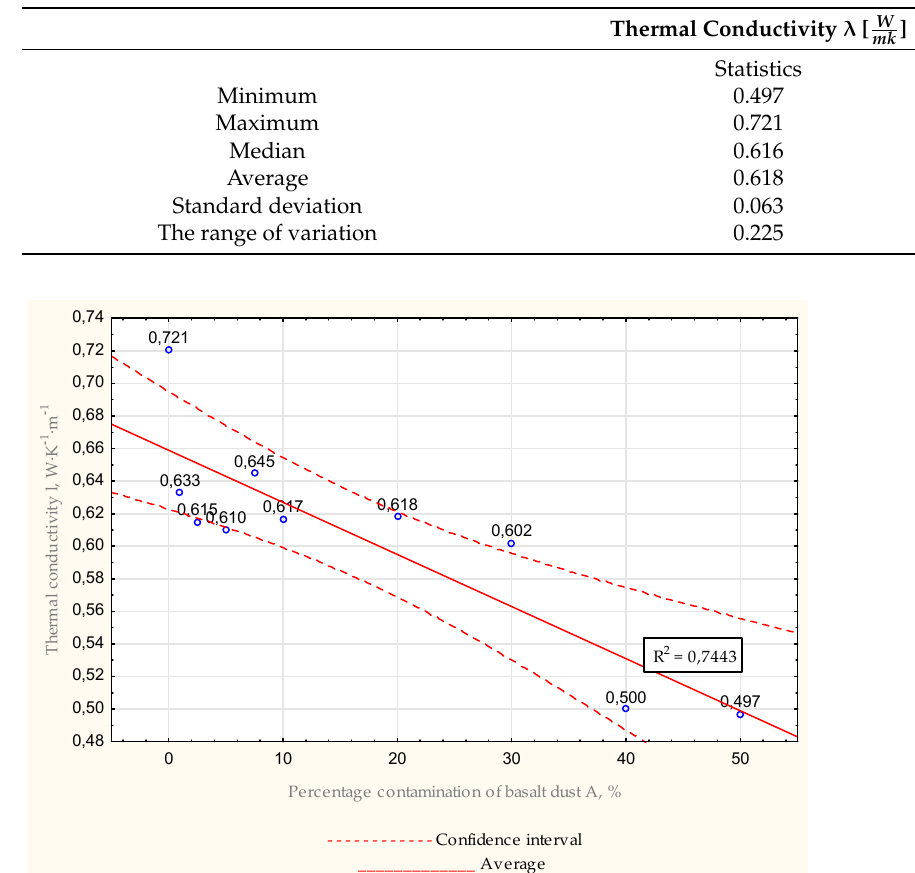
Table 6. Average thermal conductivity for basalt dust A for all samples for water − mix ratio = 0.6.